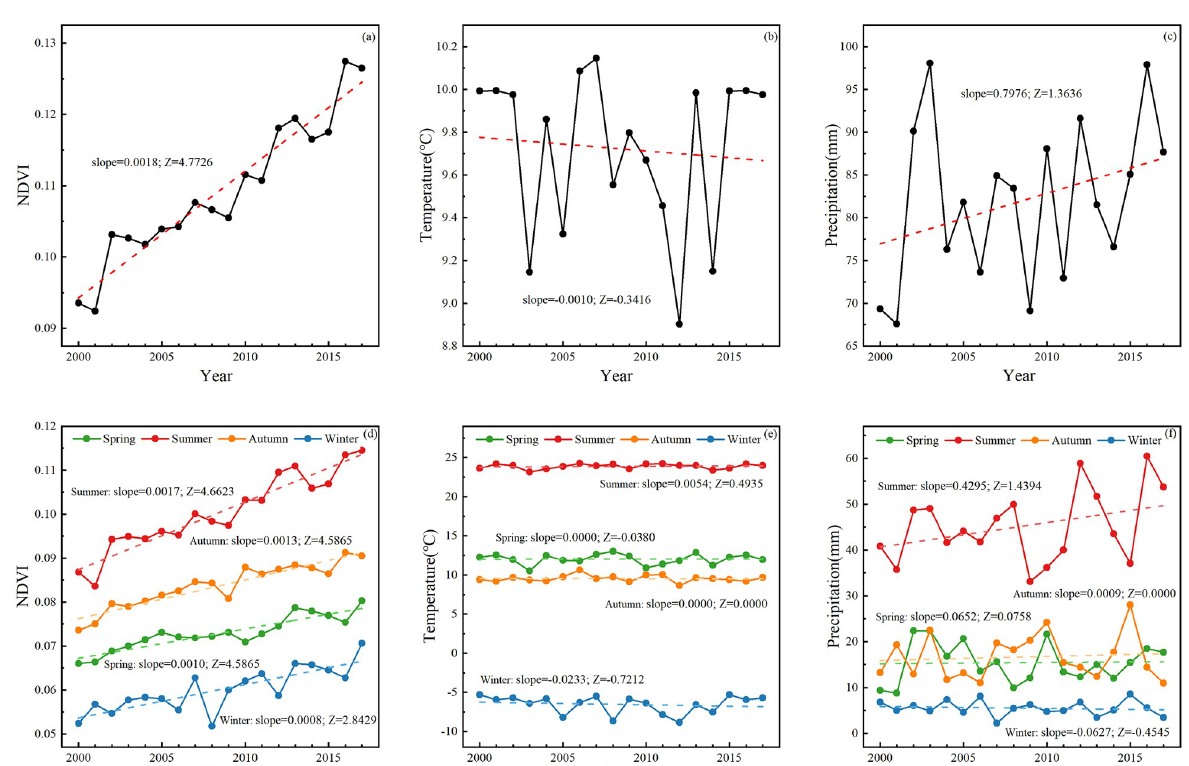
Fig 2. Variations and trends in annual precipitation (a), temperature (b), and NDVI (c), and seasonal NDVI (d), temperature (e), and precipitation (f) in desert areas from 2000 to 2017. https://doi.org/10.1371/journal.pone.0256462.g002 Spatial differences in greening and browning trends Greening and browning trends indicated by the annual NDVI. On the annual scale, the deserts showed greening trends spatially (Fig 4), with 62.8% of the area showing greening trends, mainly on the desert margins, especially on the southern edge of the Gurbantunggut Desert, in the northwestern part of the Taklimakan Desert, and in the Kubuqi Desert. Only 0.78% of the area showed browning trends, distributed in the northeastern Taklimakan Desert and the eastern Qaidam Basin Desert.